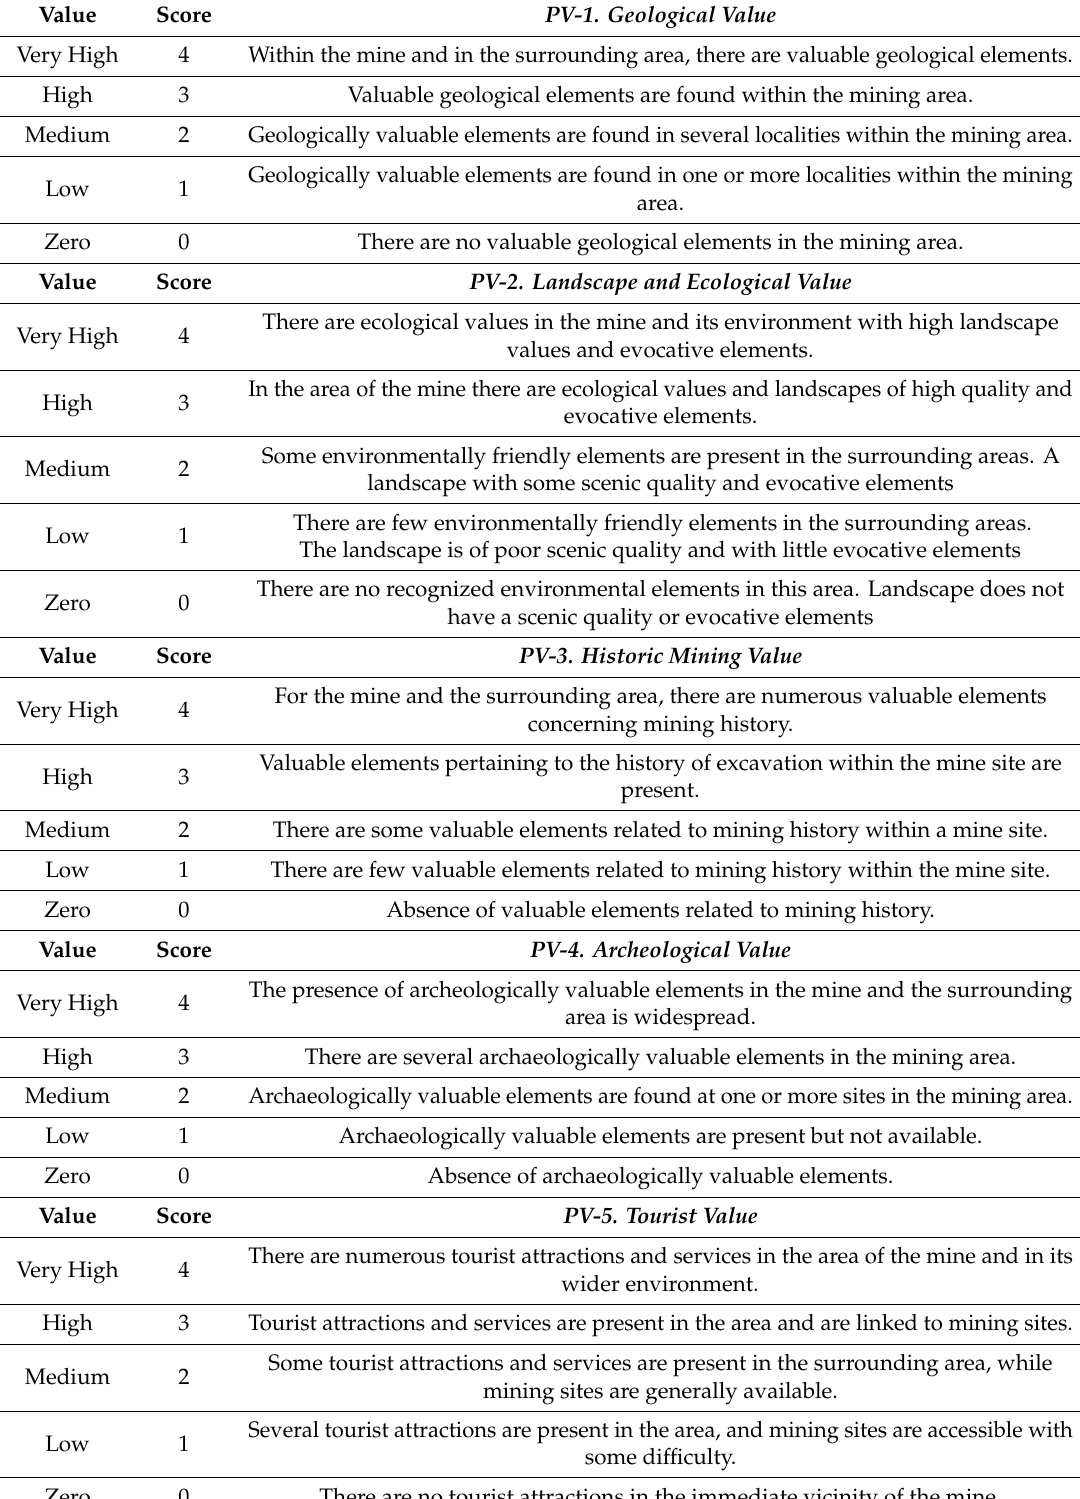
Table 3. Evaluation scores for positive values ( PV